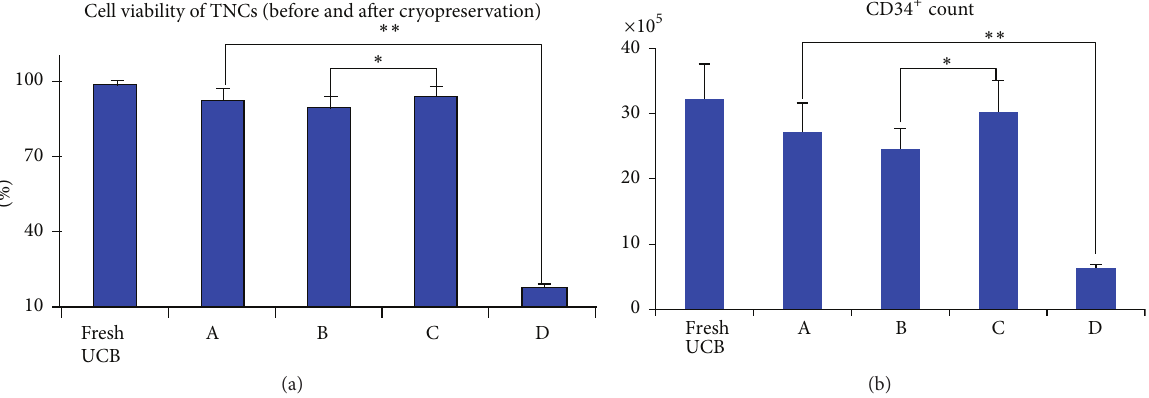
Figure 2: (a) The cell viability of group C was higher than that of groups A, B ( 𝑃 < 0.05 ) and group D ( 𝑃 < 0.01 ) after thawing. (b) The CD34 + count of group C was higher than that of groups A, B ( 𝑃 < 0.05 ) and group D ( 𝑃 < 0.01 ) after thawing.